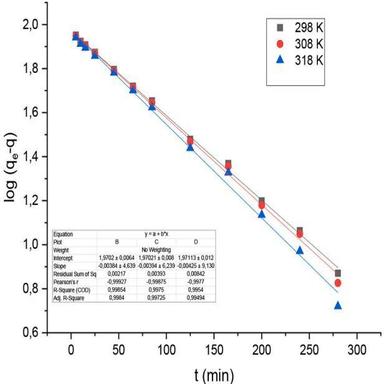
The plot of pseudo-first order kinetic.